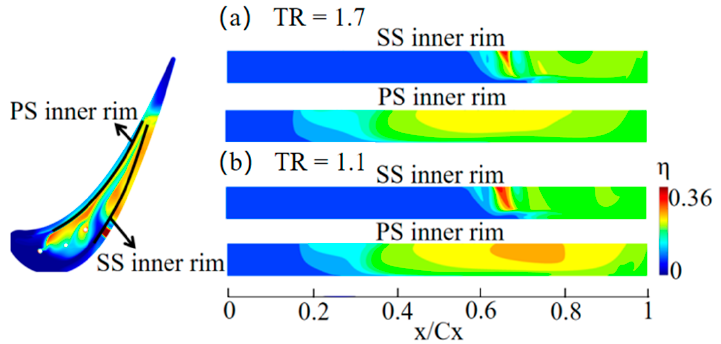
Figure 12. In the cooled case, the coolant mass fraction distribution ( η ) on the SS and PS inner rims under ( a ) TR = 1.7 and ( b ) TR = 1.1.